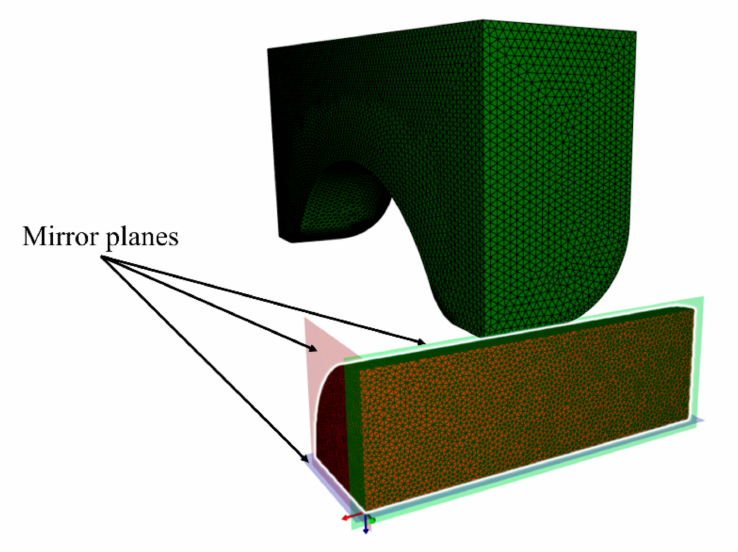
Figure 4. Symmetry of the FEM-modelling of the representative